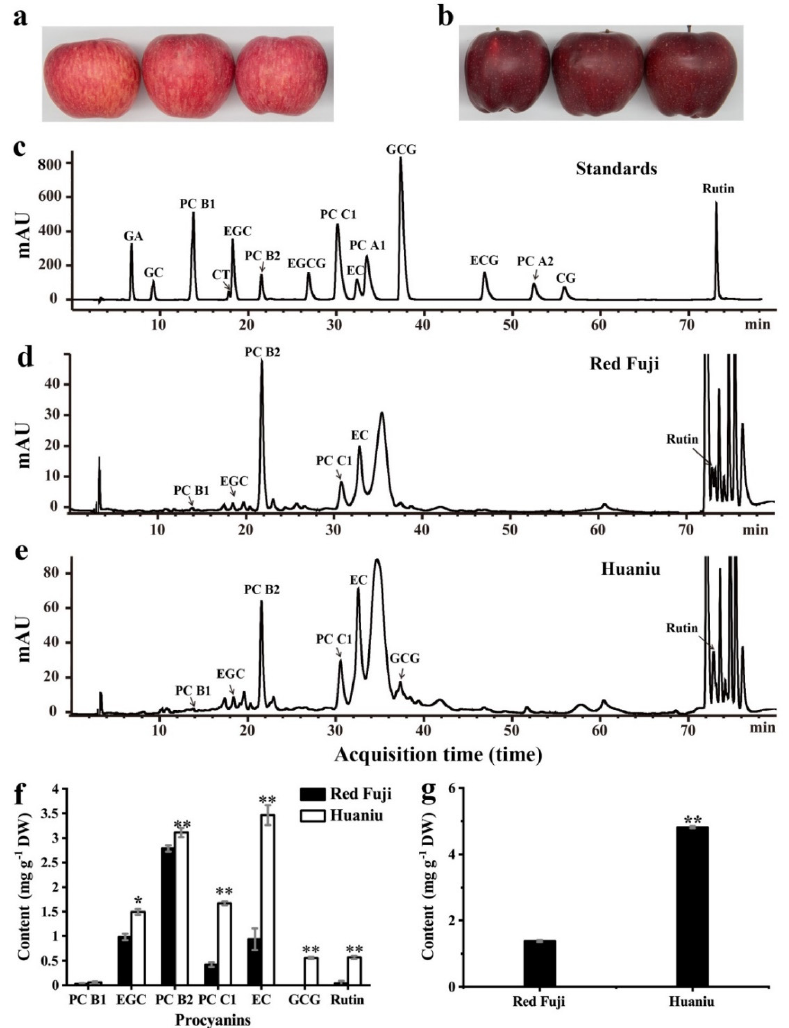
Figure 1. Contents of flavan-3-ols, procyanidins (PCs) and anthocyanins in red Fuji and Huaniu peels. ( a , b ) Images of ( a ) red Fuji and ( b ) Huaniu apples. ( c ) HPLC chromatogram of standards of flavan-3-ols and PCs. ( d , e ) HPLC chromatogram of flavan-3-ols and PCs extracted from ( d ) red Fuji and ( e ) Huaniu peels. ( f ) Contents of flavan-3-ols and PCs in Huaniu and red Fuji peels. ( e ) Contents of anthocyanins in Huaniu and red Fuji peels. Values are means of three biological repeats. Error bars indicate standard errors of means (SEMs) of the values. Asterisks indicate significant differences between Huaniu and red Fuji peels by Student’s t-test (* p < 0.05; ** p < 0.01). GA: gallic acid; GC: (+)-gallocatechin; CT: (+)-catechin; EGC: ( − )-epigallocatechin; EGCG: ( − )-epigallocatechin gallate; EC: ( − )-epicatechin; GCG: ( − )-gallocatechin gallate; ECG: ( − )-epicatechin gallate; CG: ( − )-catechin gallate; PC: